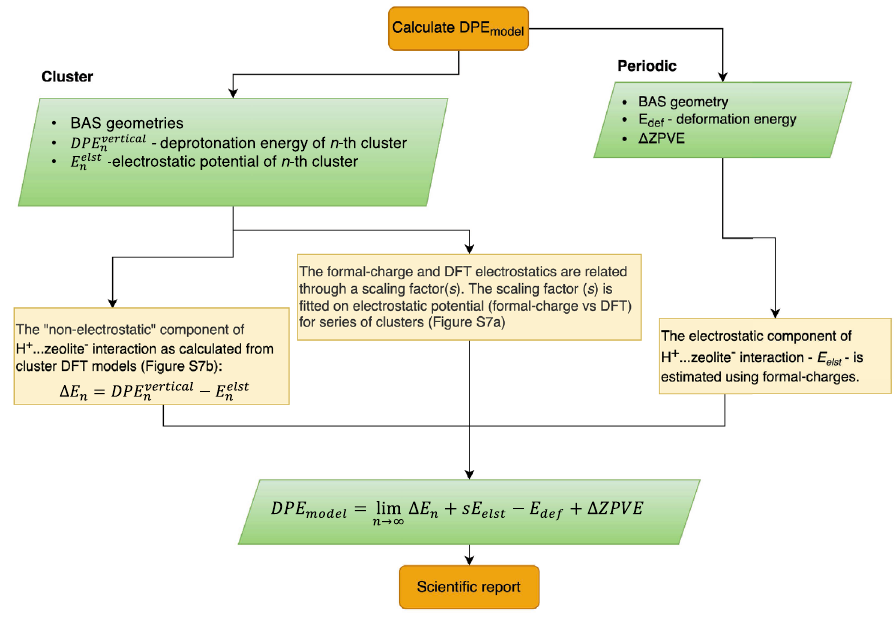
Figure 3. The electrostatic embedding model to calculate deprotonation energy (see also Figure S6).